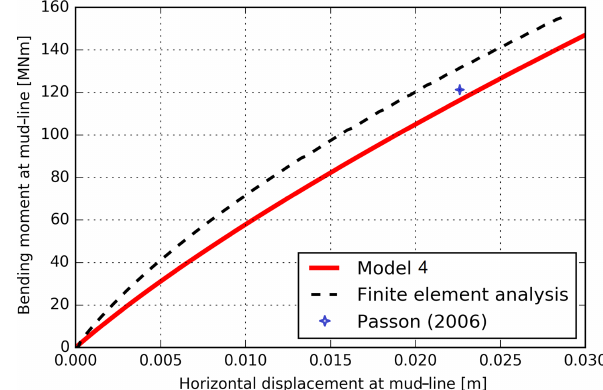
Figure 15. Computed moment–horizontal displacement curve at mud-line from finite element analyses and from the calibrated Model 4. The representative moment and rotation at mud-line used in the calibration from Passon (2006) are included as a reference.